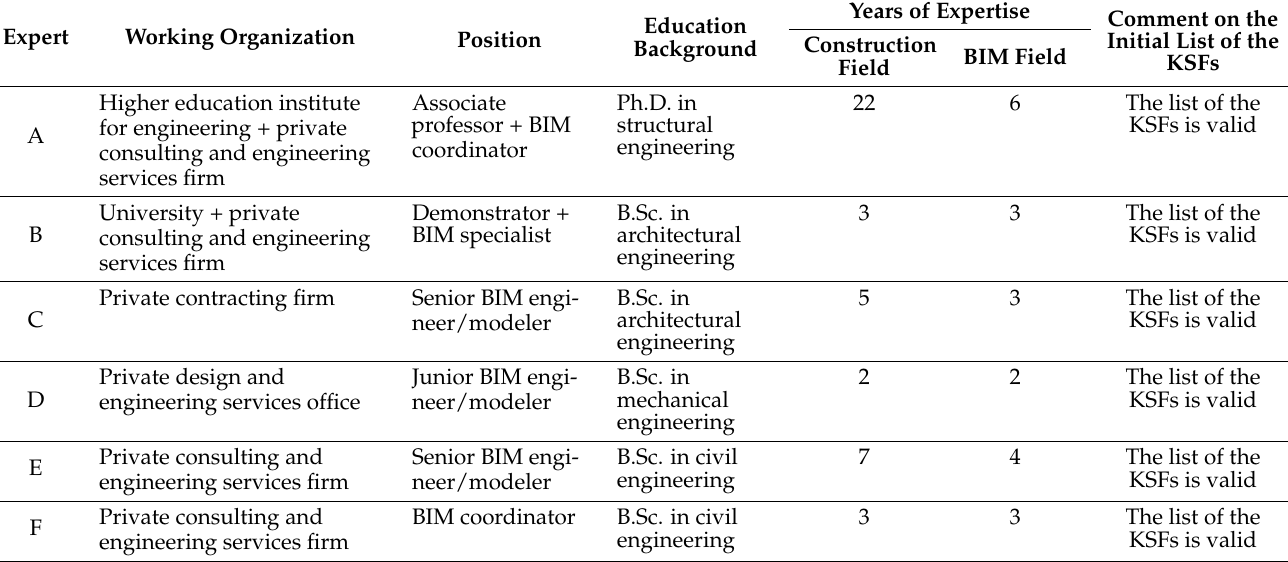
Table 2. Background of the entrants in validating the list of the